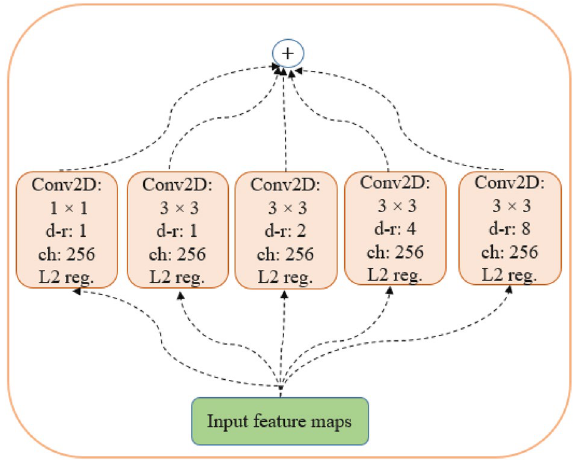
Figure 8. Architecture of the proposed context perception boosting